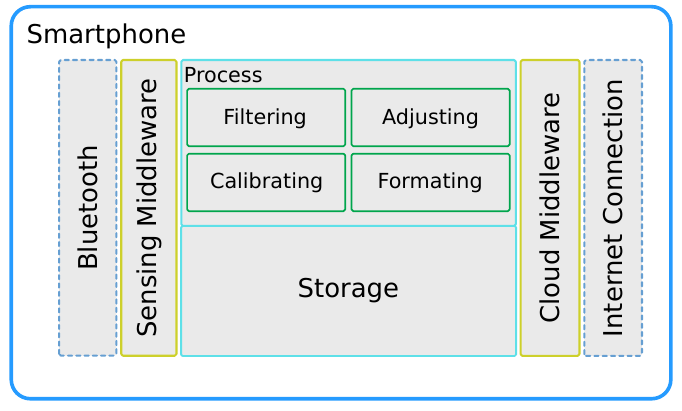
Figure 11. Smartphone software architecture